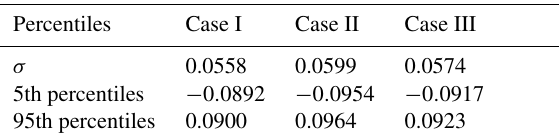
Table 2. Standard deviation ( σ ) and the 5th and the 95th percentiles of the hourly step-change functions per rated wind power capacity for the three optimized lumped power output time series displayed in Fig.